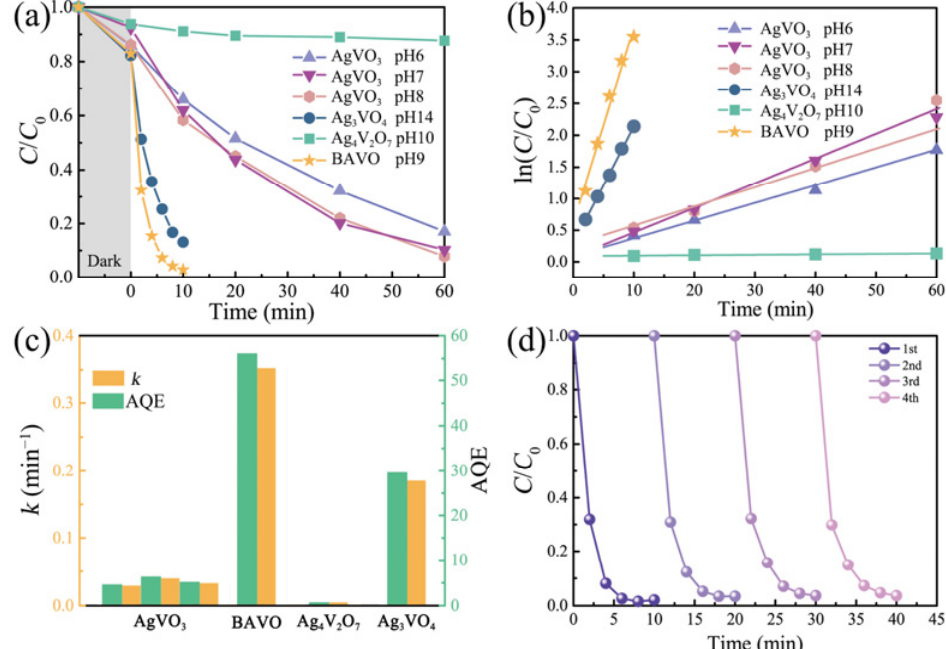
Fig. 6 Photocatalytic performance of all the silver vanadates and BAVO heterojunction for RhB degradation under visible light irradiation: (a) photodegradation of RhB by AgVO 3 (pH = 6–8), Ag 3 VO 4 (pH = 14), Ag 4 V 2 O 7 (pH = 10), and BAVO heterojunction (pH = 9); (b) pseudo-first-order kinetic curves and fitting results; (c) degradation rate constants ( k ) and AQEs of the silver vanadates; and (d) cycling tests of BAVO